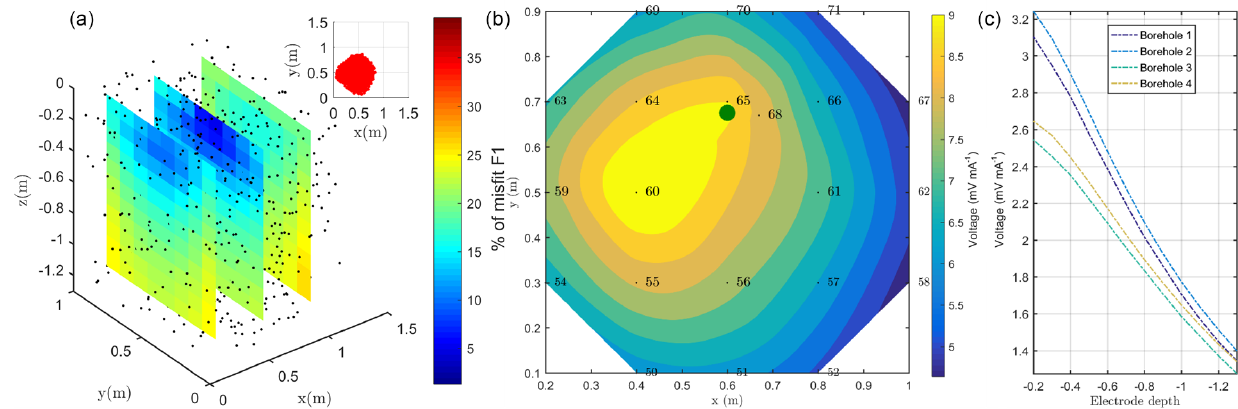
Figure 5. (a) Spatial distribution of F1: the black dots show the virtual source locations. In the top right corner, the selected sources (for a misfit of 17%) inferred from the study of the cumulative sum of the misfit (or curvature); (b) inverted model obtained after sources ponderation considering the distributed function F2 for surface electrodes. The green point shows the positions of the plant stem (c) for borehole electrodes.